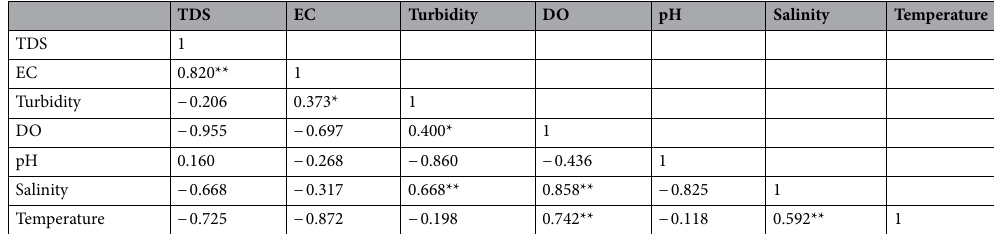
Table 3. The Pearson’s correlation analysis between physicochemical properties of water samples. * TDS total dissolved oxygen, EC electrical conductivity, DO dissolved oxygen. **Correlation is significant at the 0.01 level (2-tailed), *Correlation is significant at the 0.01 level